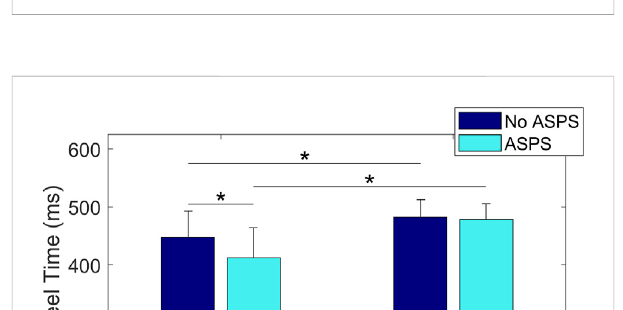
Mean and standard deviation of sled acceleration for all subjects and all trials ( n = 224).